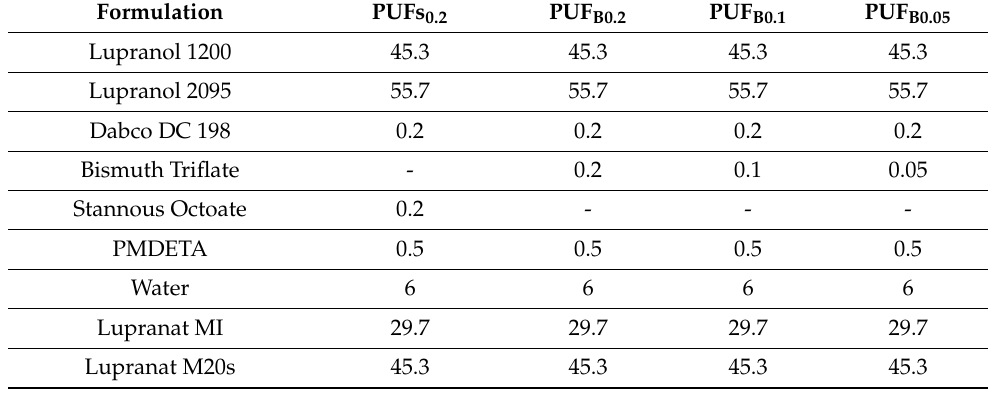
Table 1. Formulations of PU foams expressed as parts per hundred of polyol.